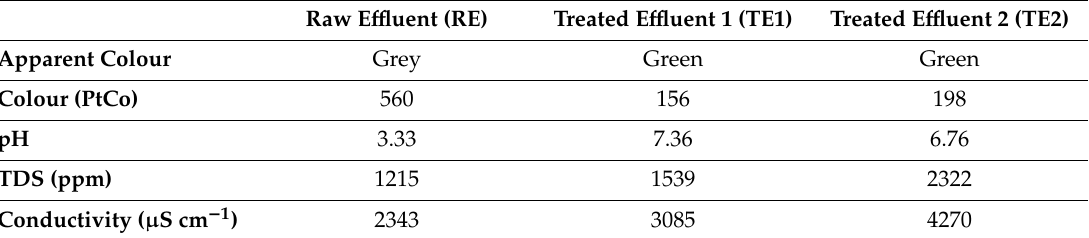
Table 1. Characterisation of the e ffl uent used in the toxicity